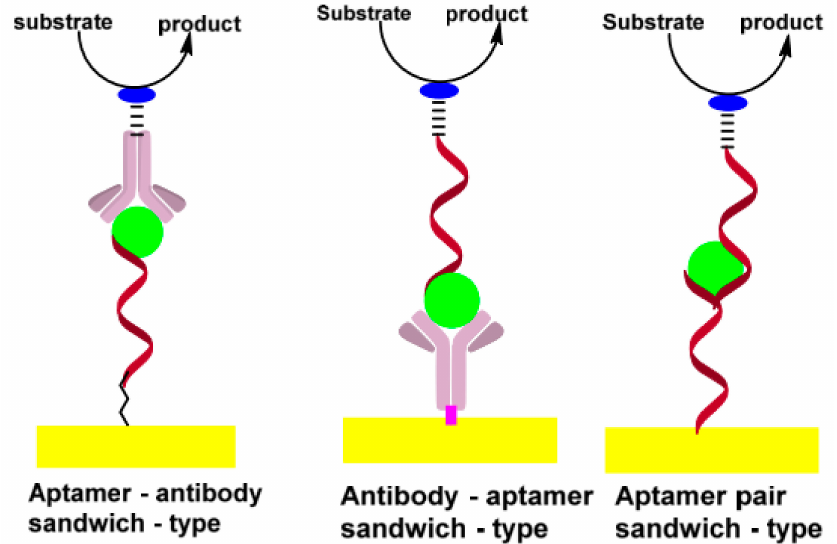
Figure 3. Schematic representation of sandwich-type structures employed in aptasensing assays. Reprinted from